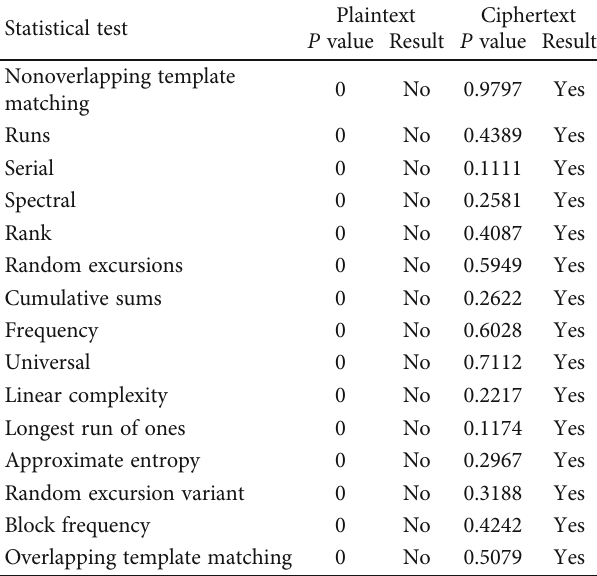
Table 1: NIST test of plaintext and ciphertext. Plaintext Statistical test